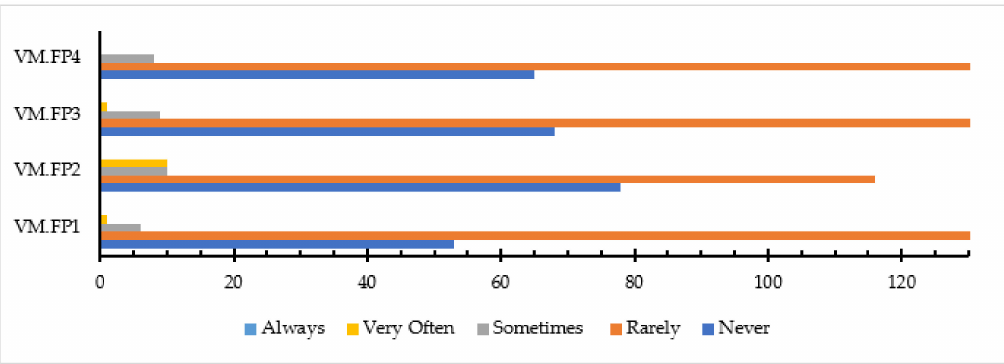
Figure 6. Frequency distribution for the function